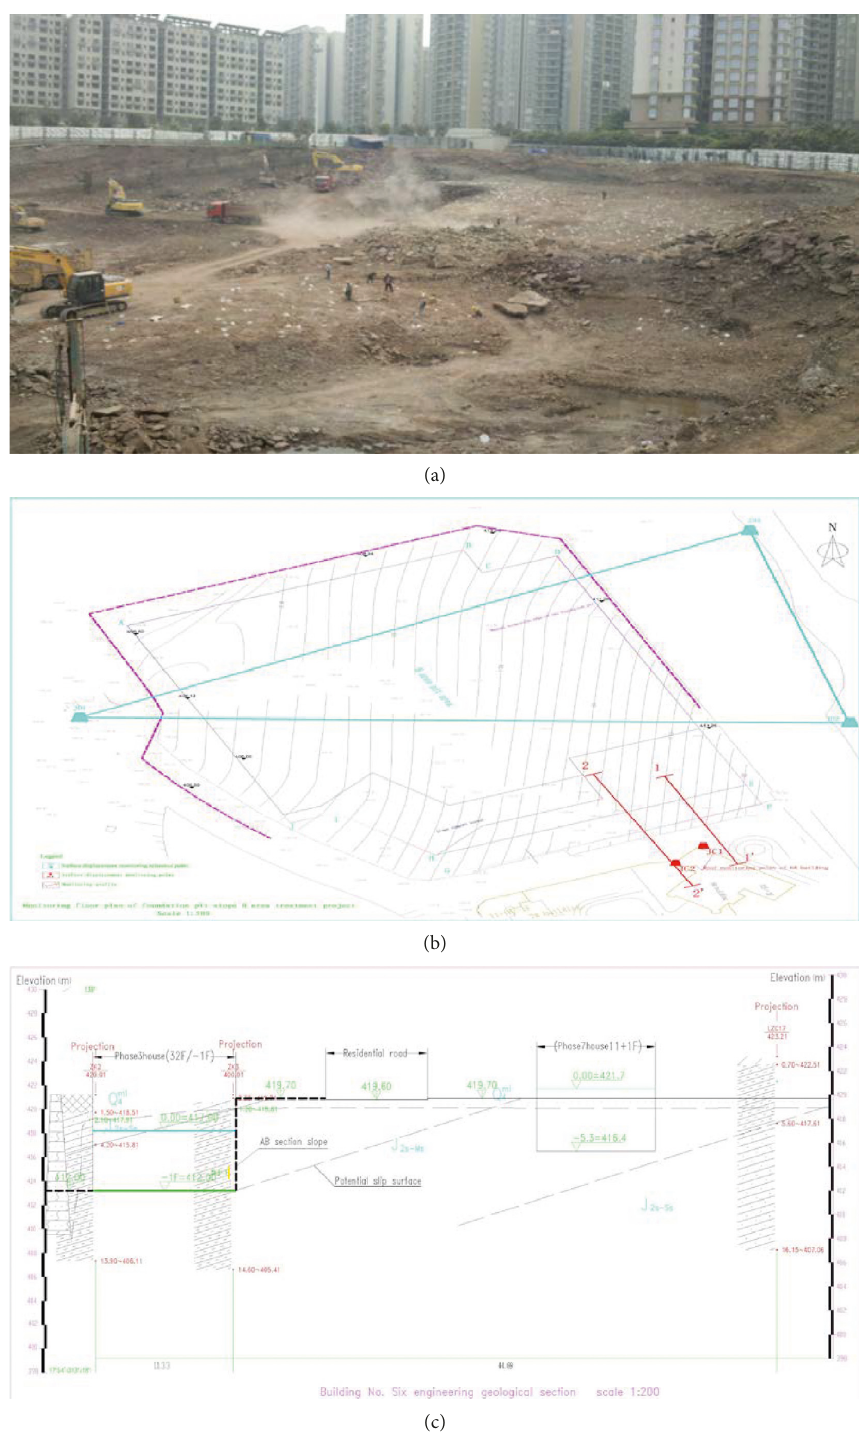
Figure 2: Deep foundation pit slope, monitoring layout, and engineering geological section: (a) whole panorama of deep foundation pit slope; (b) monitoring floor plan of foundation pit slope B district treatment project; (c) Building No. Six engineering geological